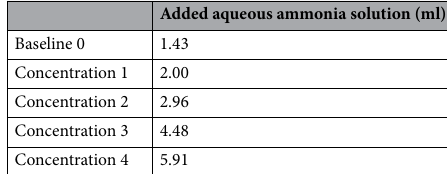
Table 4. The amount (ml) of added aqueous ammonia solution for samples with an initial volume of 25 ml for one selected measuring series.